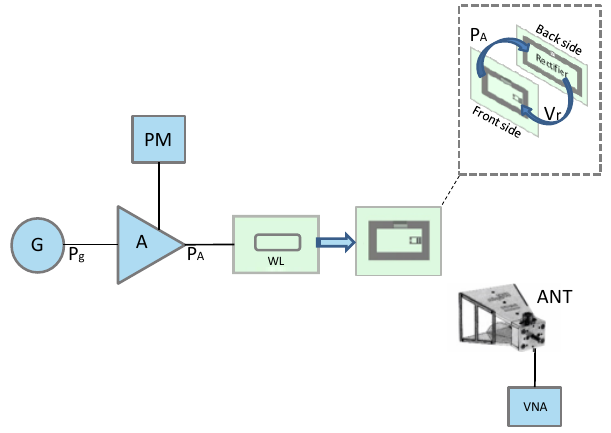
Figure 10. Schematic diagram of the entire system. Table 5. The components used for communication with the sensor tag.